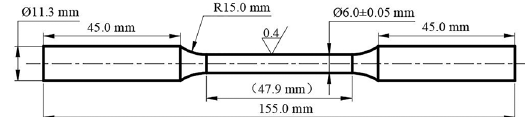
Figure 3. Specimen size drawing.